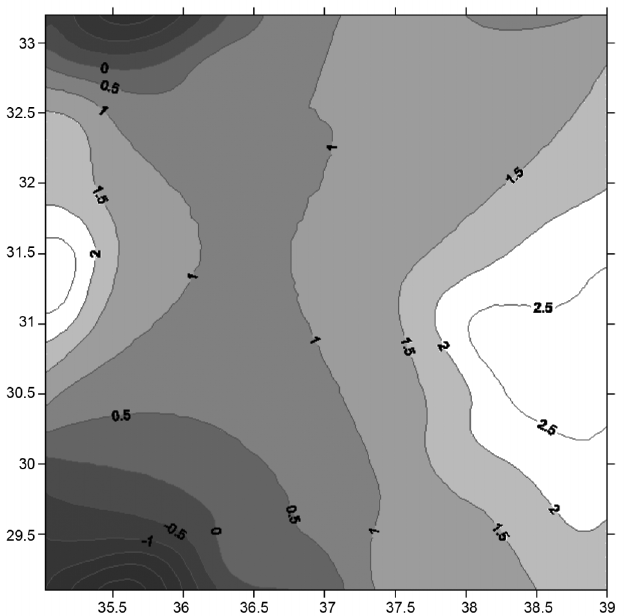
Fig. 6. The differences in meters, between the two models created in Jordan using OSU91A and EGM9 (lati- tude and longitude in